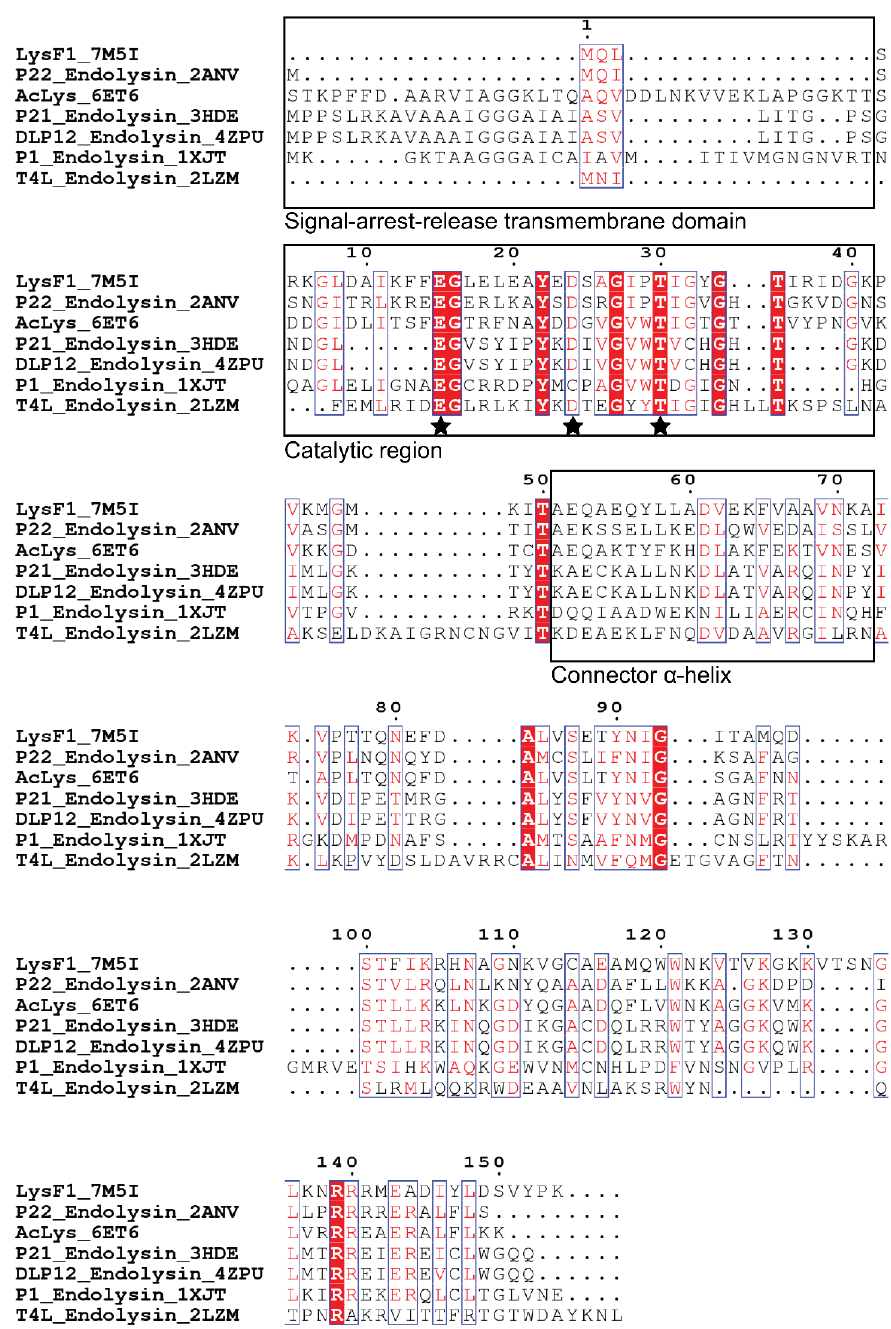
Figure 1. Sequence comparison of LysF1 with six closely related endolysins. Structural features of these endolysins are marked with black boxes and symbols. Putative catalytic residues are marked with a star symbol. Red boxes indicate a conserved residue. Red letters indicate similarity within a group and blue frames indicate similarity across a group.